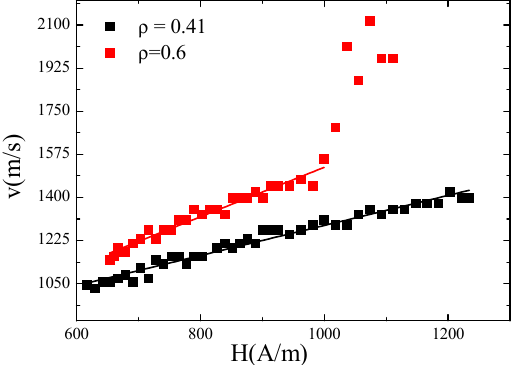
Figure 13. Hysteresis loops of Fe 38.5 Co 38.5 B 18 Mo 4 Cu 1 microwires with ρ = 0.41 ( a ) and ρ = 0.6 ( b ) annealed at 300 °C, 450 °C and 500 °C measured at f = 50 Hz. Reproduced from reference [70], Figure 6.